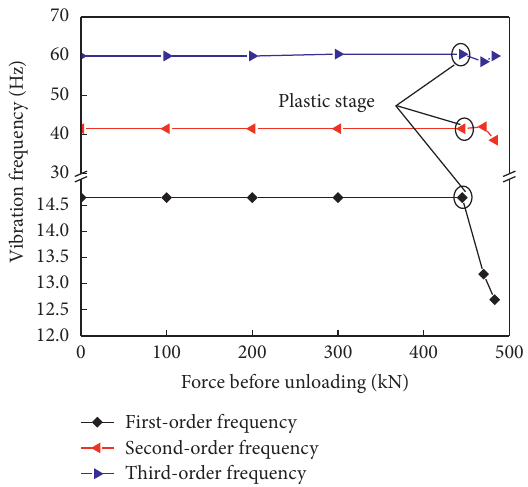
Figure 16: First three-order vibration frequency of JD1beam.